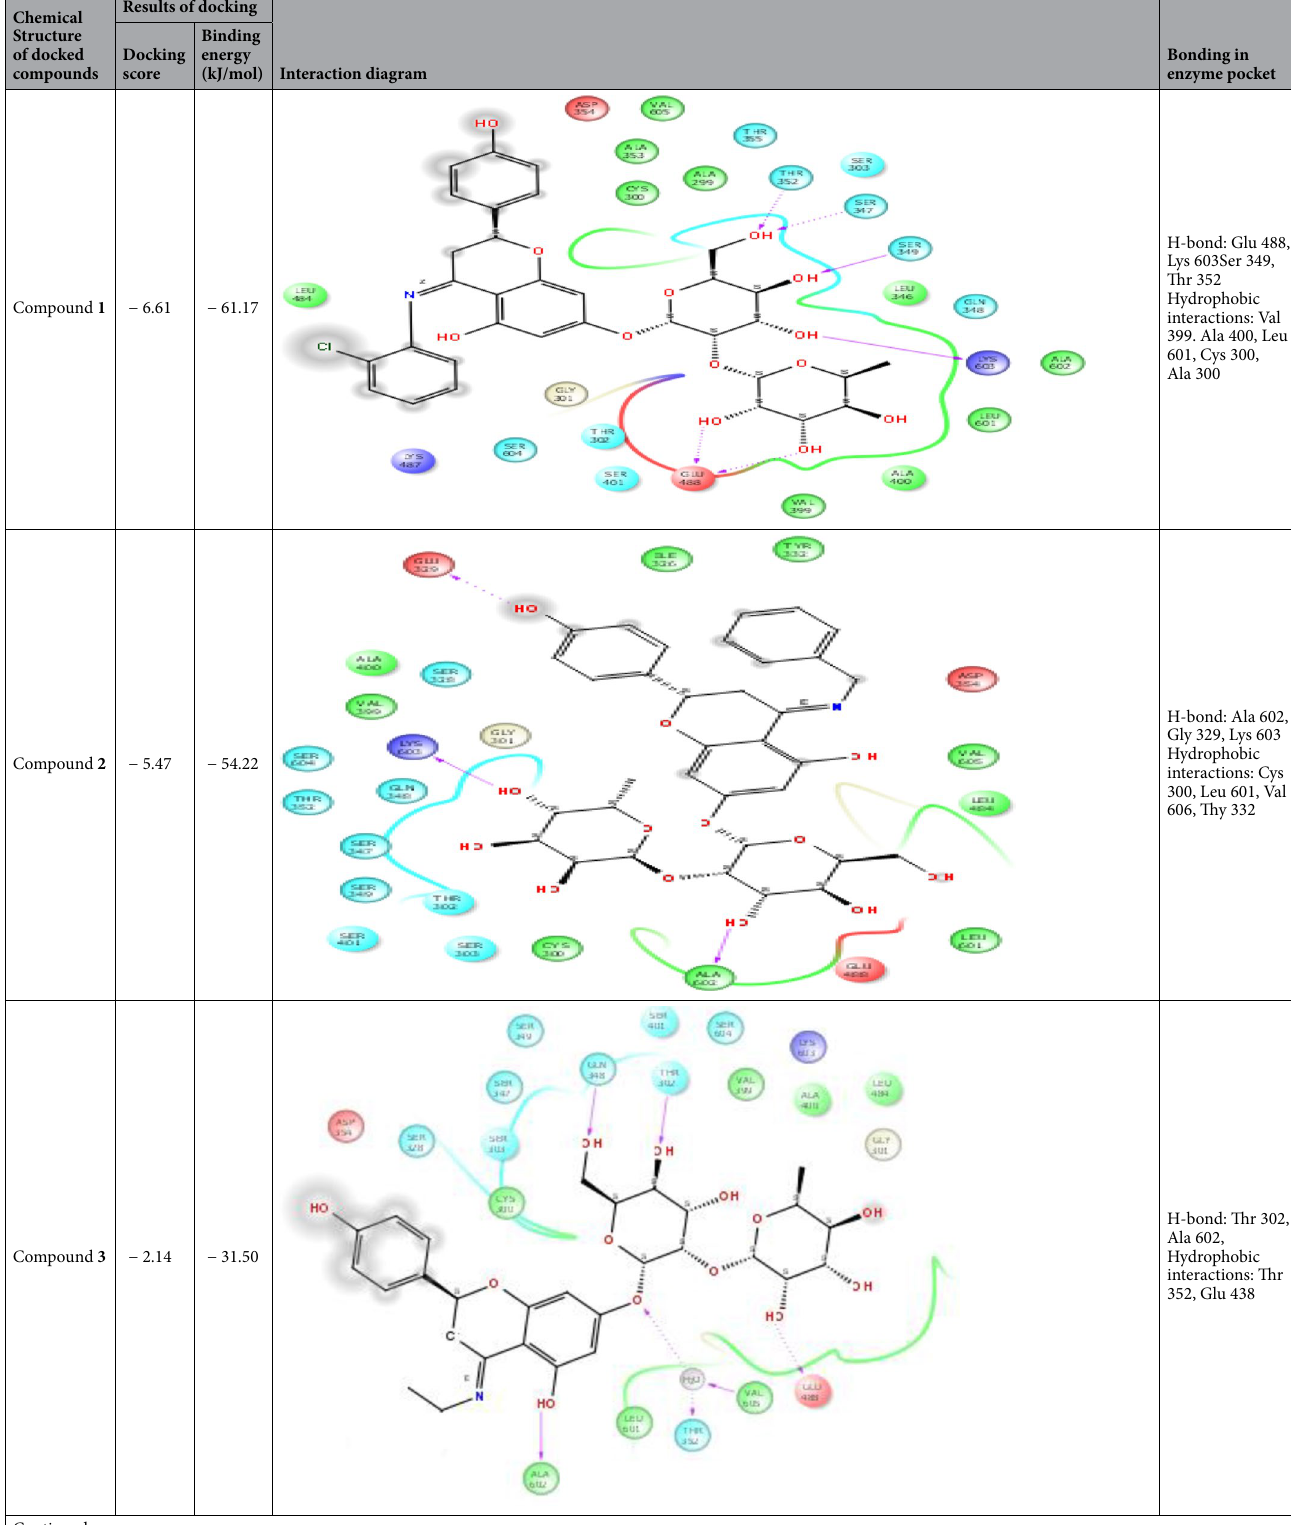
H-bond: Thr 302, Ala 602, Hydrophobic interactions: Thr 352, Glu